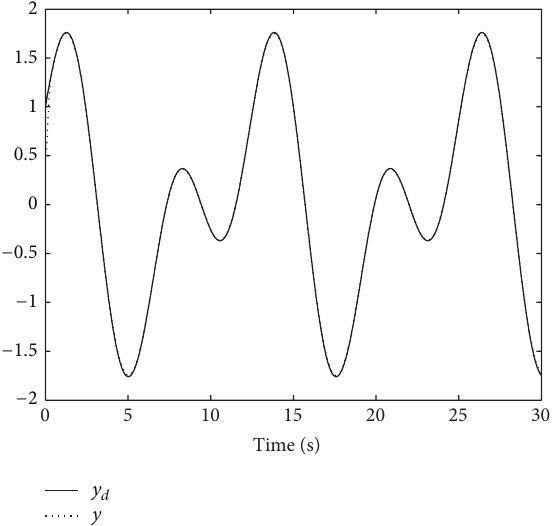
Figure 4: The curve of adaptive parameters